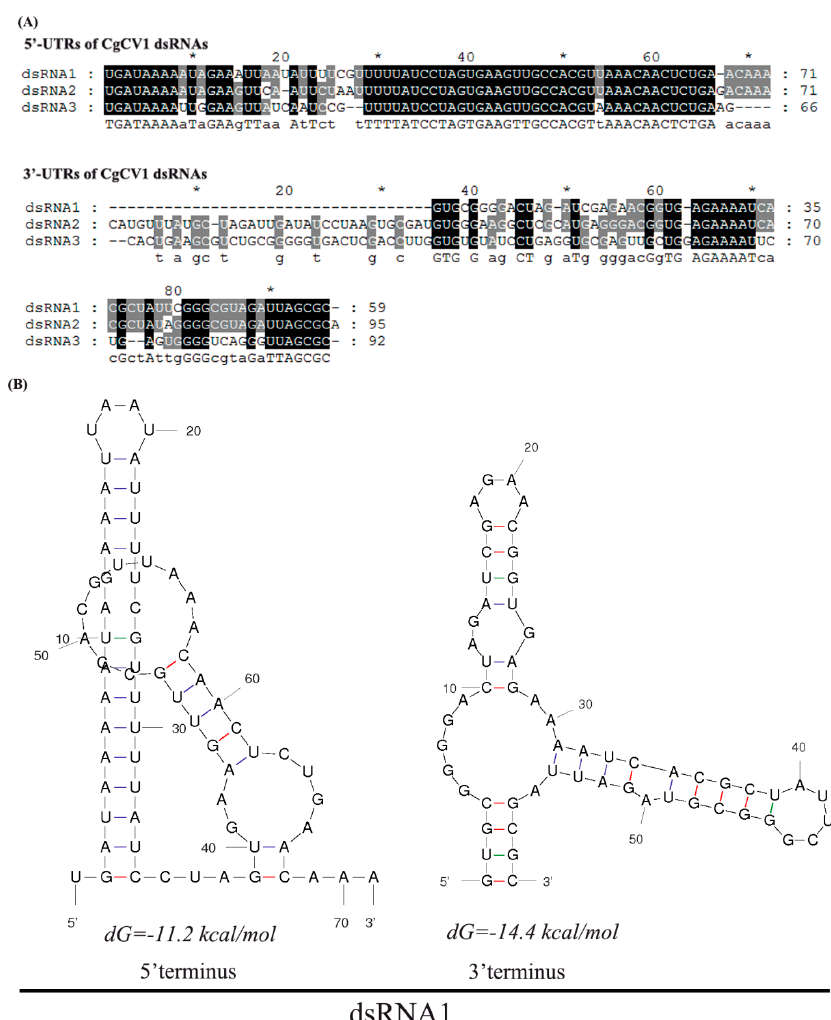
Figure 3. Terminal sequence comparison and secondary structure prediction of the coding strand of CgCV1 dsRNAs. ( A ) Conserved regions among the three dsRNAs in the 5 ′ or 3 ′ terminus are indicated with black shading; ( B ) secondary structures in the 5 ′ and 3 ′ terminal regions of CgCV1 dsRNA1 were predicted by the Mfold program with the lowest energies.